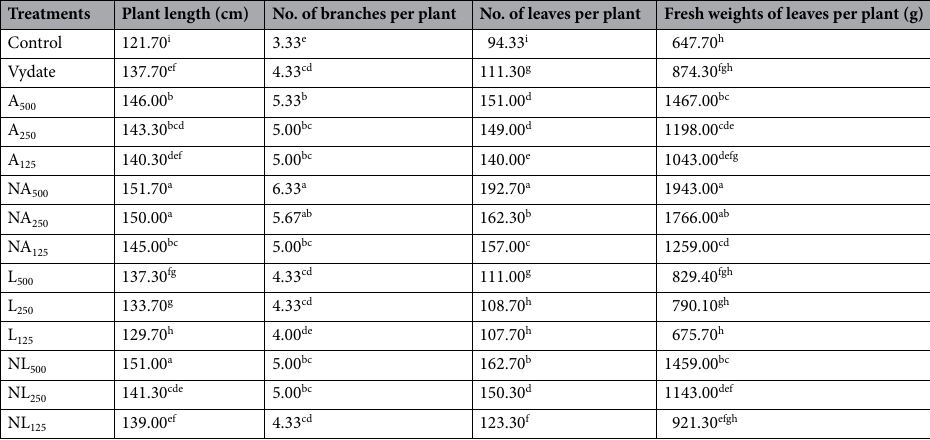
Table 3. Effect of A. annua and L. sativum extracts and their nano-formulations on vegetative growth parameters of tomato plants. Means followed by the same letter(s) are not significantly (P < 0.05) different.